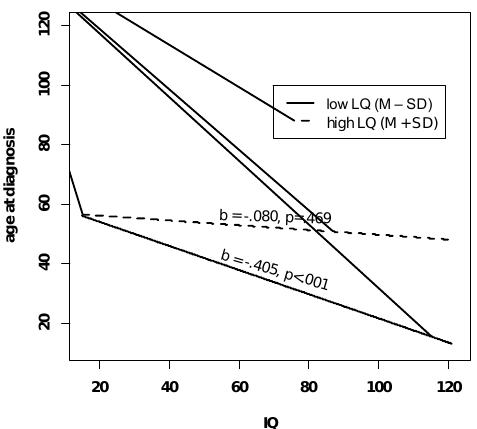
Figure 2. Interaction between LQ and IQ. Note. M = mean, SD = standard deviation. IQ = Non-Verbal Developmental Quotient. LQ = composite language score. b = unstandardised regression coefficient for IQ at high levels of LQ (M + SD) and low levels of LQ (M – SD).